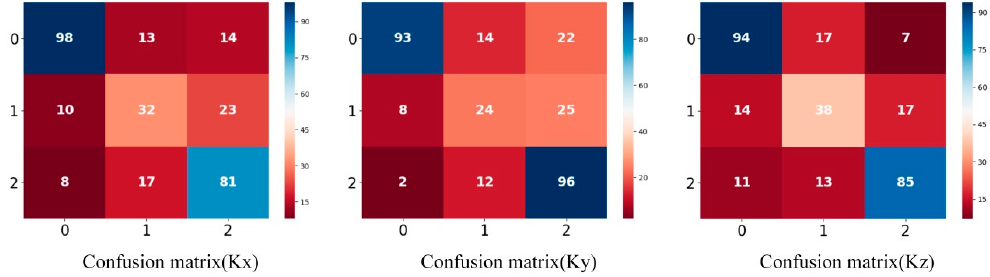
Figure 8. Confusion matrix of stiffness based on MAV1 (0 = high stiffness, 1 = middle stiffness, 2 = low stiffness).